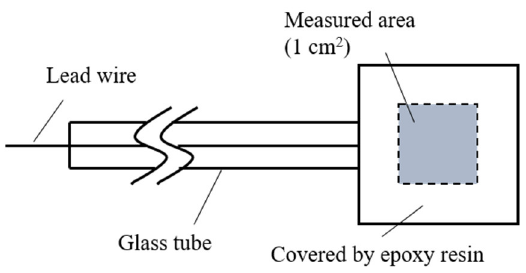
Figure 2. Schematic of specimen used for spontaneous potential and galvanic current measure- ments.